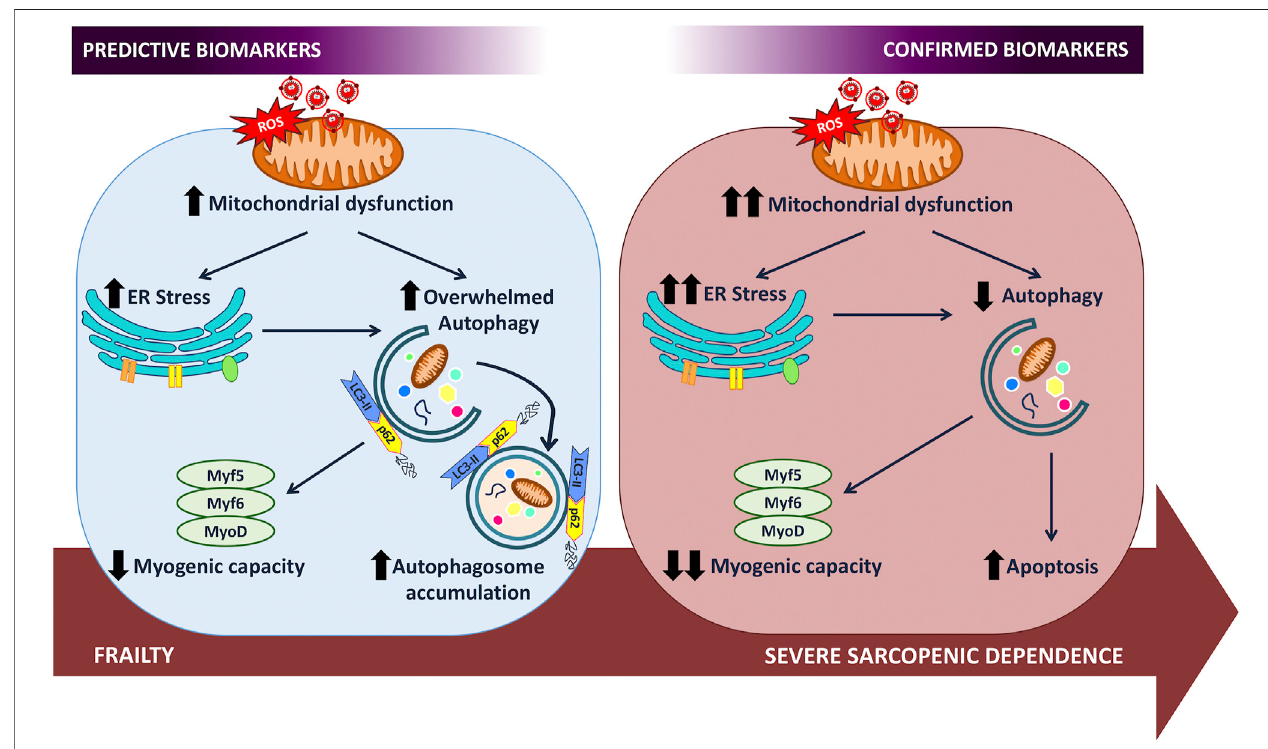
FIGURE 1 | The study of the evolution of the frailty interactome that determines predictive biomarkers of sarcopenic dependence.